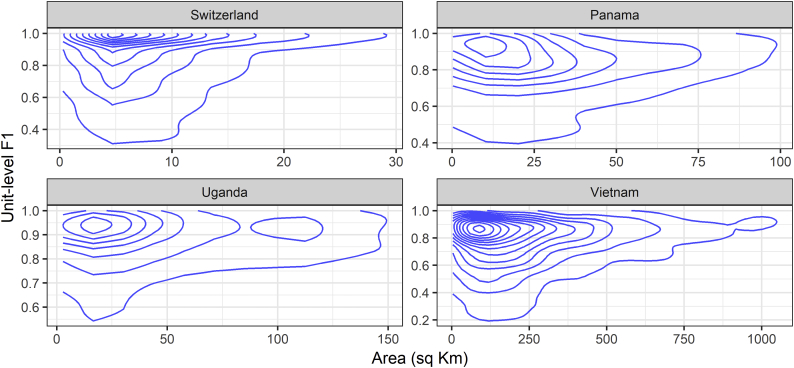
Contour density plot of unit-level F1 scores by country across all predicted years. Created using a two-dimensional kernel density estimation (Venables & Ripley, 2002).